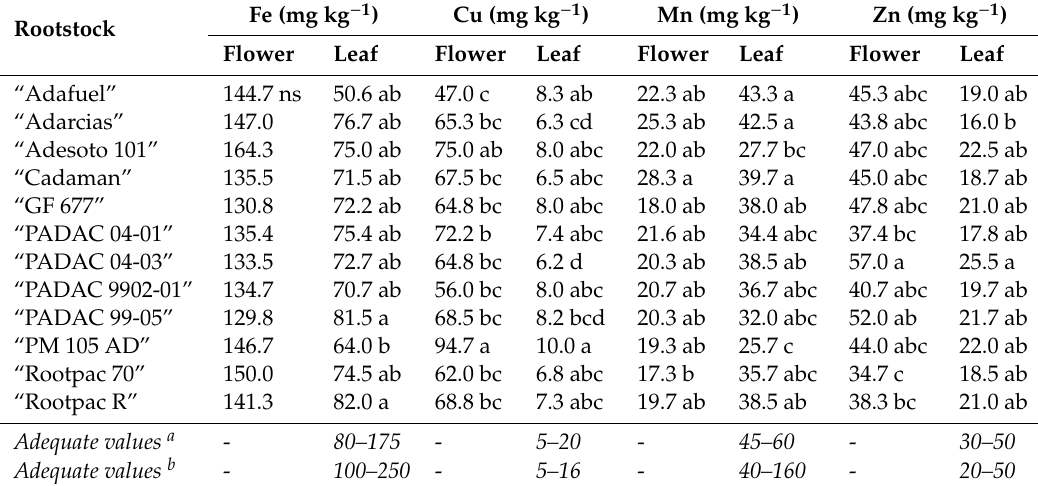
Table 10. Rootstock e ff ect on flower and leaf micro elements for “Big Top” nectarine cultivar budded on 12 Prunus rootstocks at the ninth year after